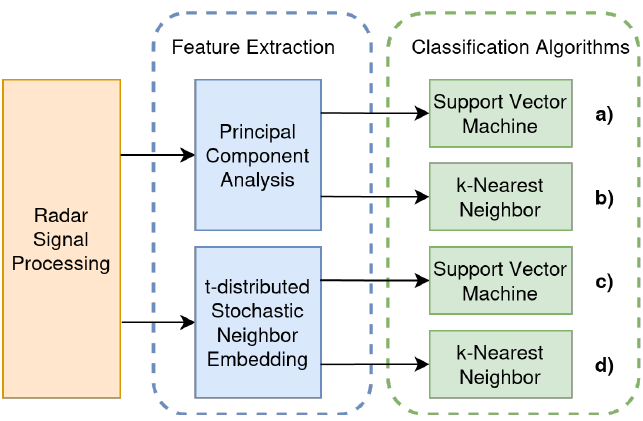
Figure 7. Walking classification system designs explored in [25]; ( a ) Principal component analysis combined with support vector machine classification; ( b ) Principal component analysis combined with k-nearest neighbor classification; ( c ) t-distributed stochastic neighbor embedding combined with support vector machine classification; ( d ) t-distributed stochastic neighbor embedding combined with k-nearest neighbor